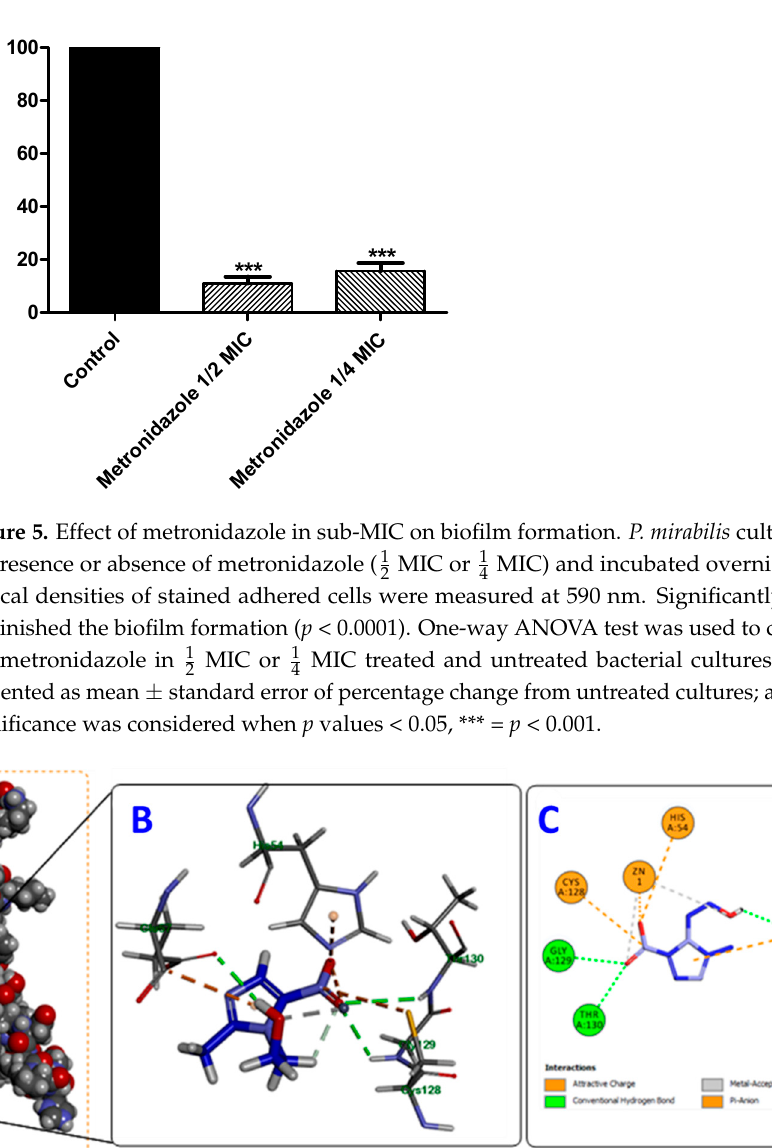
Table 2. The susceptibility of isolated P. mirabilis to antibiotics in presence of Metronidazole (¼ MIC). Antibiotic